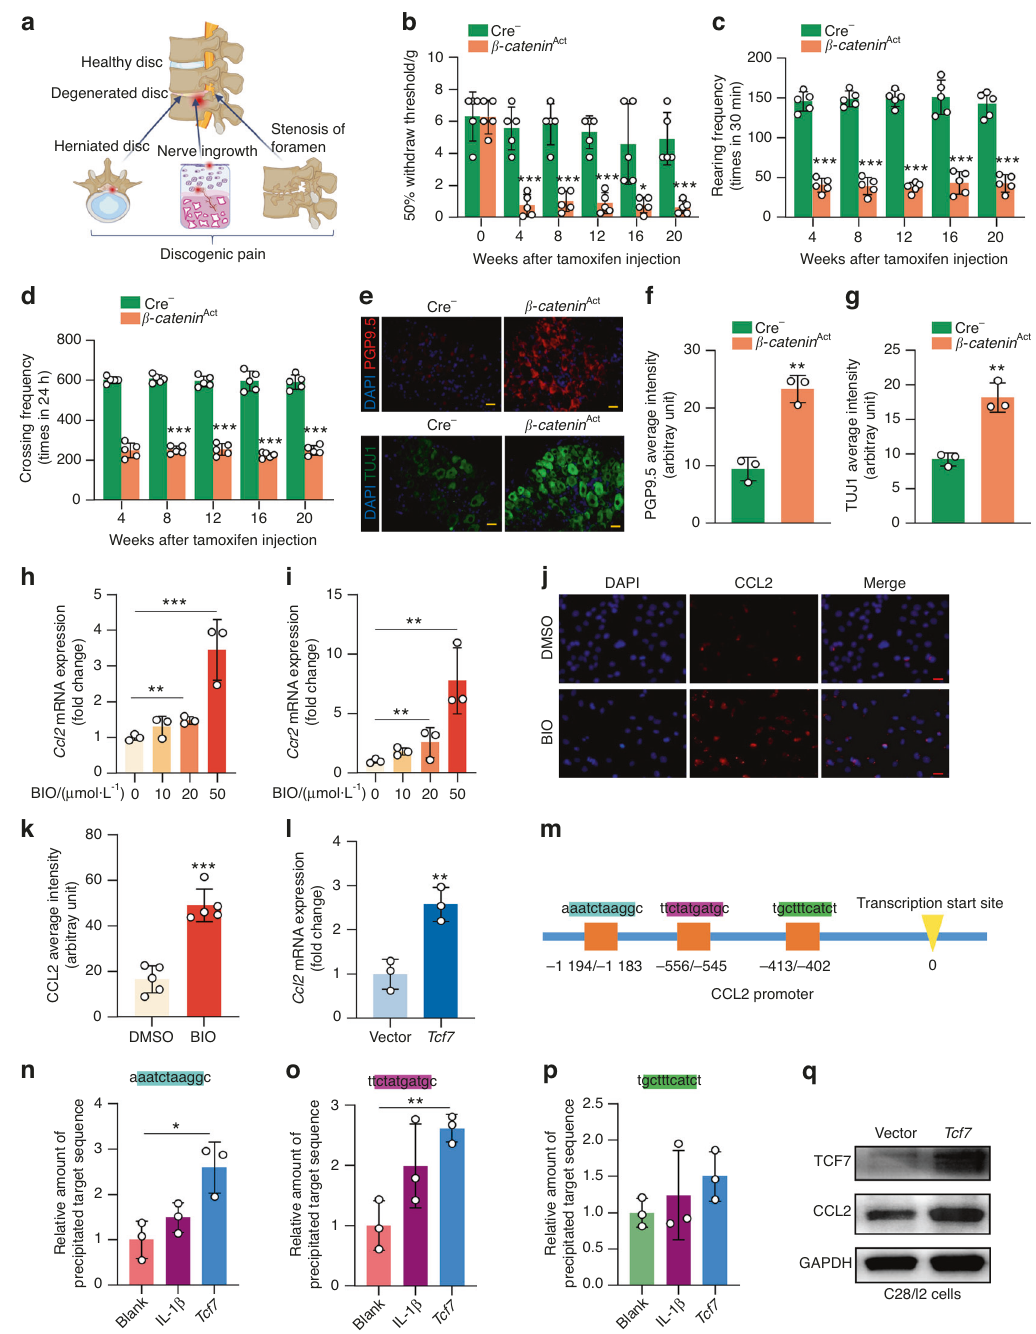
Fig. 5 Activation of β -catenin causes discogenic pain. a A schematic diagram illustrating three reasons for discogenic pain. b – d The von Frey test and LABORAS test showing the sensitivity to mechanical allodynia ( b ), rearing number ( c ) and crossing frequency ( d ) in β -catenin Act mice compared with their Cre − littermates with tamoxifen injection at the indicated time points ( n = 5). e – g Representative IF images ( e ) (scale bar 25 μ m) showing PGP9.5 ( f ) and TUJ1 ( g ) expression in dorsal root ganglia (DRG) tissues in β -catenin Act mice and Cre − littermates ( n = 3). h , i qRT ‒ PCR of CCL2 ( h ) and CCR2 ( i ) mRNA levels in C28/I2 cells treated with the GSK-3 β inhibitor BIO (0, 10, 20, 50 μ mol·L − 1 ) ( n = 3), with the level in BIO (0 μ mol·L − 1 ) arbitrarily set to 1. j , k Representative IF images ( j ) (scale bar 25 μ m) and quanti fi cation ( k ) of CCL2 average intensity in C28/I2 cells treated with BIO (50 μ mol·L − 1 ) ( n = 5). l qRT ‒ PCR of CCL2 mRNA levels in C28/I2 cells transfected with TCF7 plasmid ( n = 3), with the level in the vector group arbitrarily set to 1. m – p Chromatin immunoprecipitation (ChIP) assays for binding of TCF7 to the CCL2 promoter. The binding regions were predicted by JASPAR — A database of transcription factor binding pro fi les (https://jaspar.genereg.net/) ( m ). ChIP assays were performed using HEK293T cells treated with IL-1 β or transfected with TCF7 plasmid. ChIP-enriched DNA was subjected to qPCR ( n – p ), with the level in the blank group arbitrarily set to 1. q Representative Western blots of TCF7 and CCL2 protein expression in C28/I2 cells transfected with TCF7 plasmid ( n = 3). GAPDH expression was detected as a loading control. * P < 0.05; ** P < 0.01; *** P < 0.001. Data are represented as the mean ± SD. Two-tailed unpaired Student ’ s t test analysis ( f , g , k , l ). One-way ANOVA followed by Tukey ’ s posttest for multiple